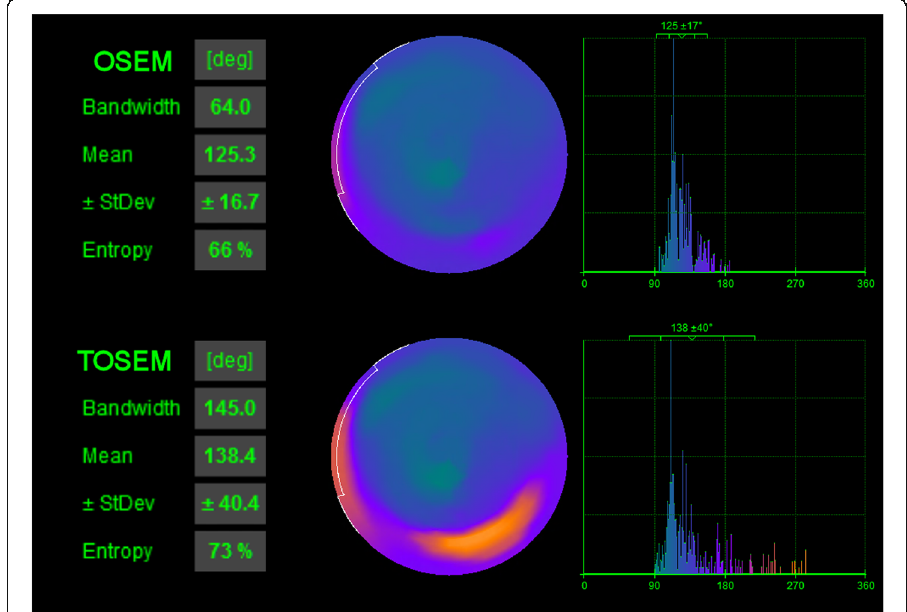
Fig. 4 Phase analysis results from Quantitative Gated SPECT 2012 program for the same patient as in Figure 1. Phase analysis assessed from OSEM-reconstructed images yielded mildly abnormal results, with the polar map showing relatively well-synchronized function. On the contrary, phase analysis assessed from TOSEM- reconstructed images yielded considerably abnormal results, with the polar map clearly showing delayed contraction in the inferior basal region of the left ventricle. For this patient, the calculated activity ratio value was